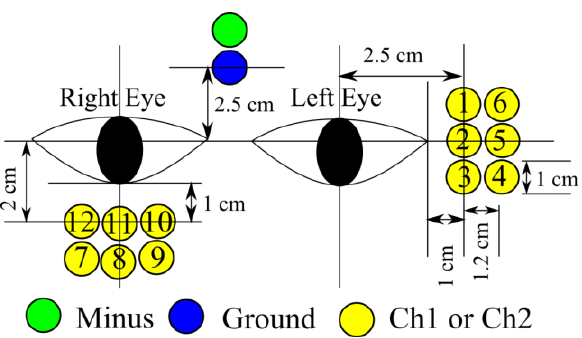
Figure 2. Possibilities of electrode positions.